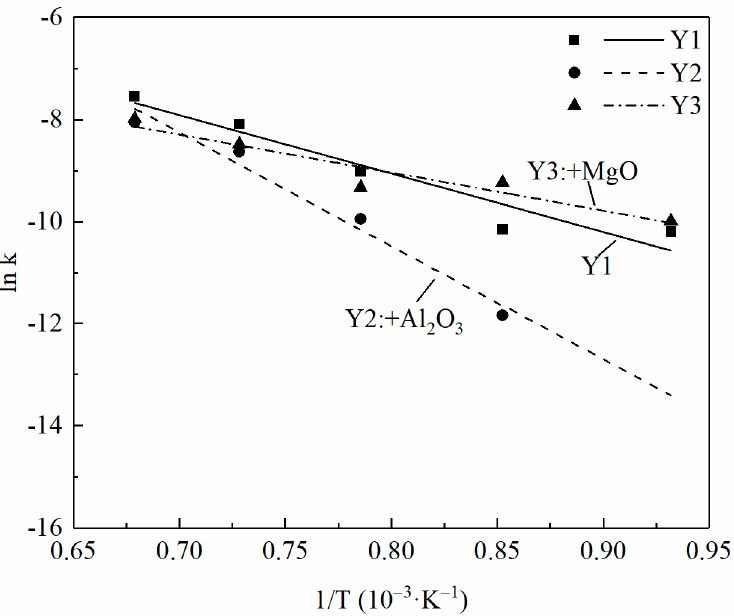
Figure 9. The relationship between ln(k) and 1/T for the reduction reaction in the chemically controlled stage; the symbols are experimental results and the lines are data fitting.